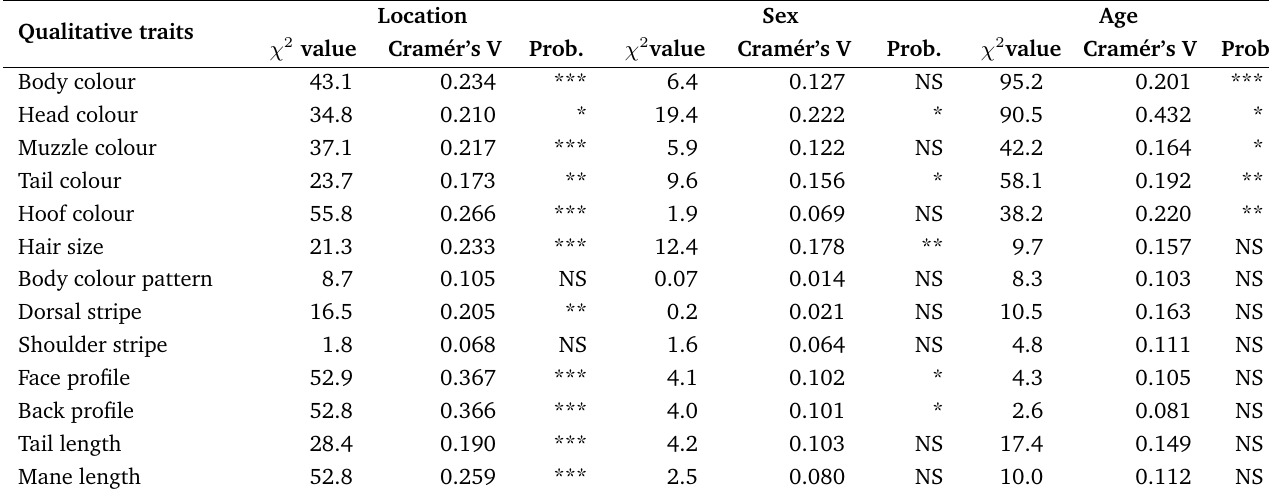
Table 14. Statistical values for chi-square and Cram´er’s V, and level of significance (probabilities) for the effects of location, sex and age on the qualitative characteristics of the studied horse populations: aggregate sex. χ 2 , chi-square; prob., probabilities; *, <